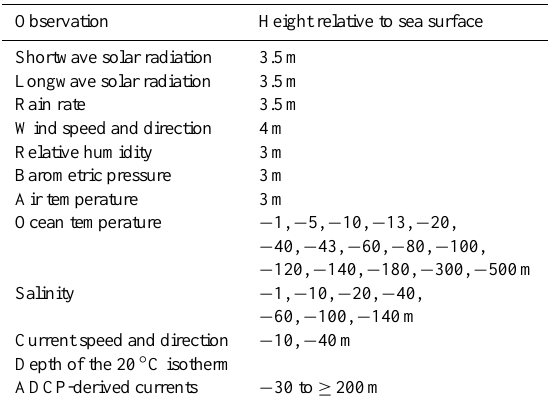
Table 1. The following observations are available from the moor- ing location (McPhaden et al., 2009). Some of these data were not available for the entire deployment due to sensor failure. Acoustic Doppler current profiler (ADCP) data are measured at 8m vertical resolution.